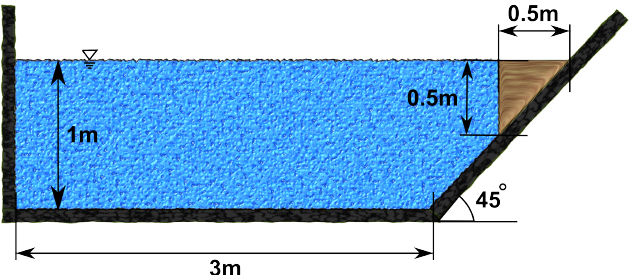
Figure 10. Geometry of the submarine landslide